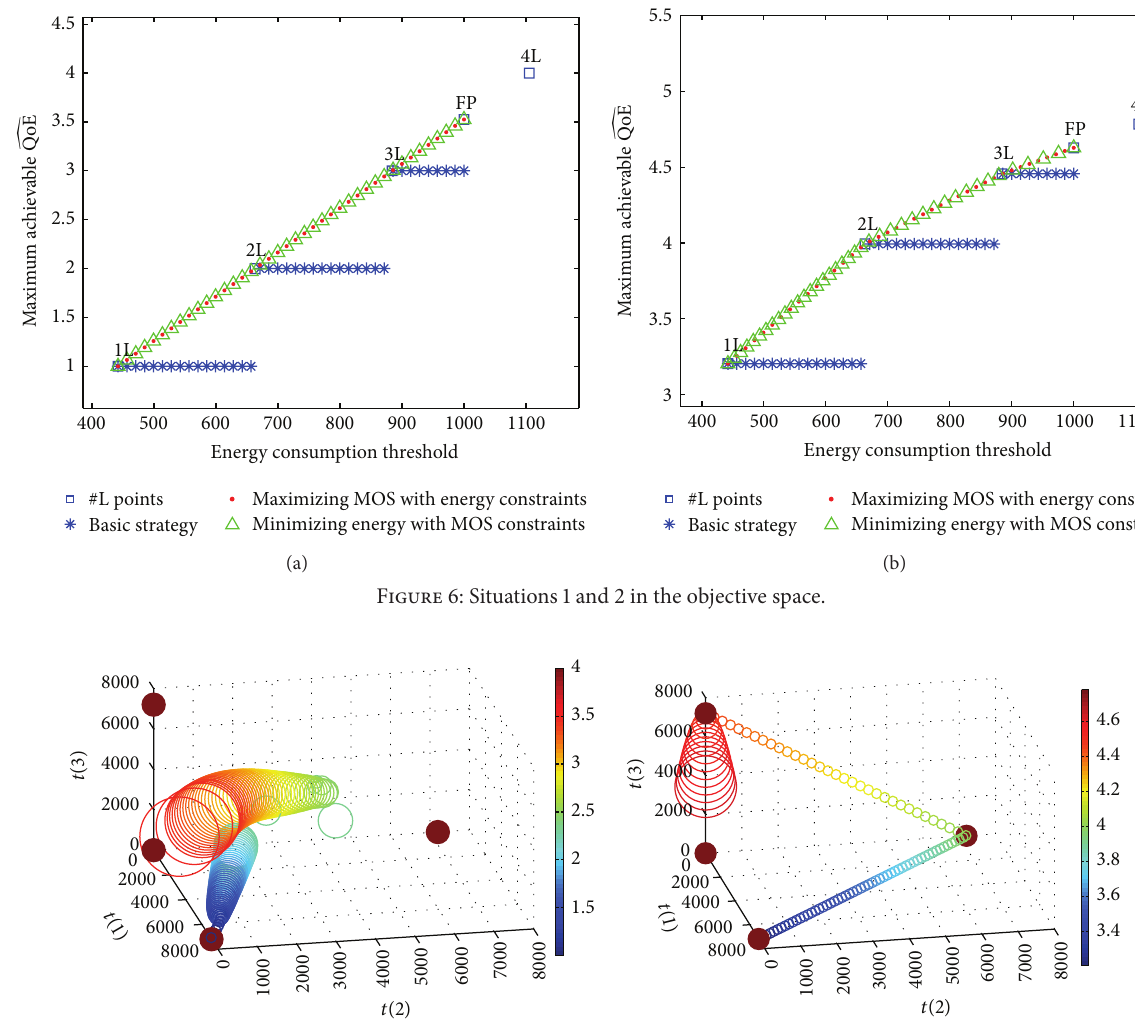
Figure 7: Situations 1 and 2 in the input